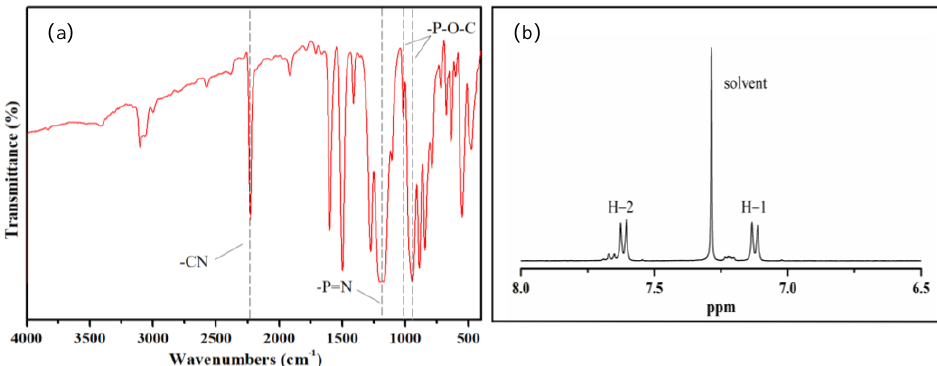
Figure 1. FTIR ( a ) and 1 H NMR ( b ) spectra of CN-CP.